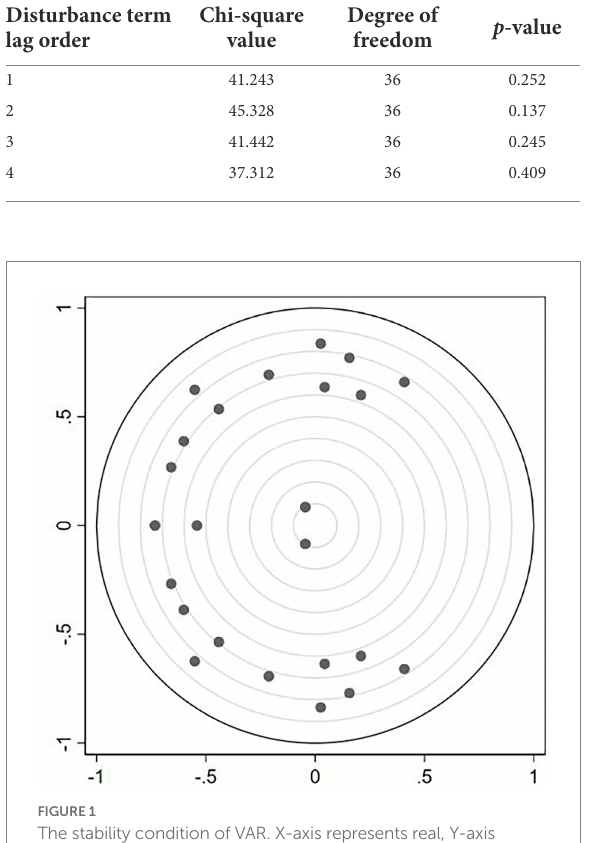
FIGURE 1 The stability condition of VAR. X-axis represents real, Y-axis represents